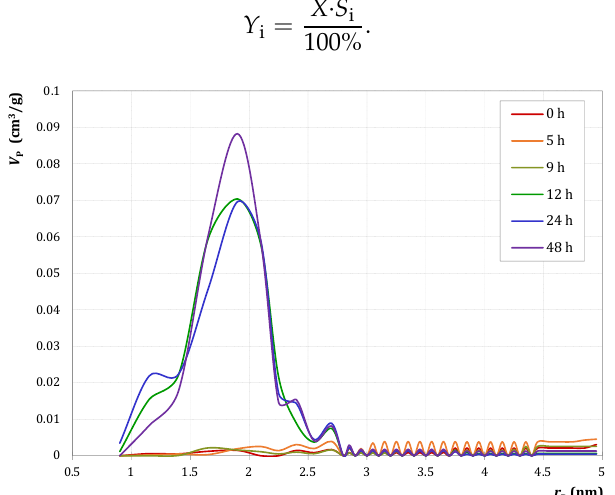
Figure A3. BJH pore radius distribution of M3 / SiO 2 90:10 mixed oxide samples with di ff erent autoclave treatment durations.